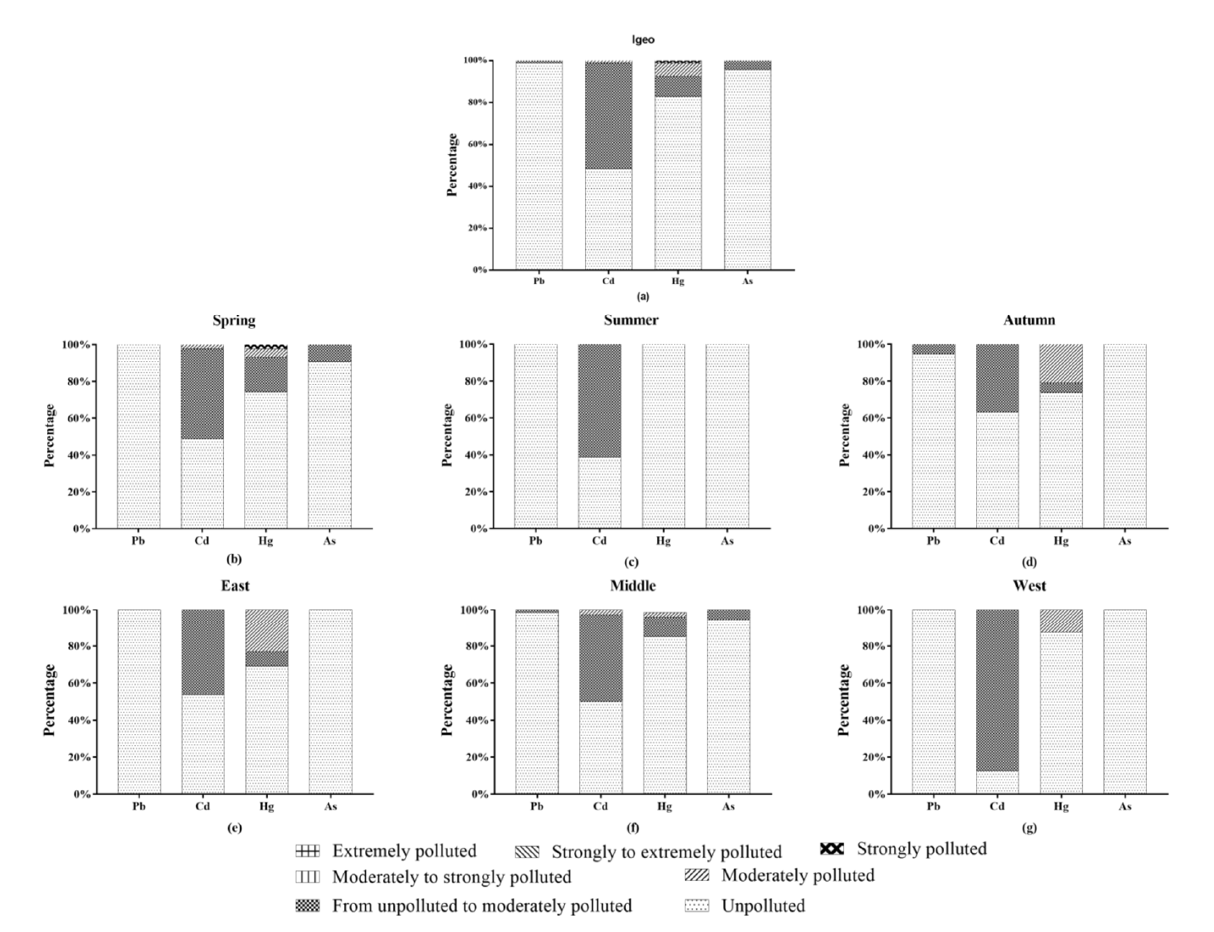
Figure 6. The results of I geo of metals in the soil: ( a ) all samples, ( b – d ) different seasons, ( e – g ) different regions.